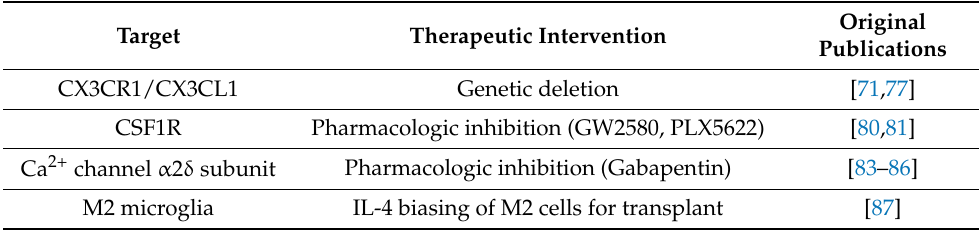
Table 2. Summary of discussed therapeutic interventions for microglial-mediated neural injury. M2: anti-inflammatory